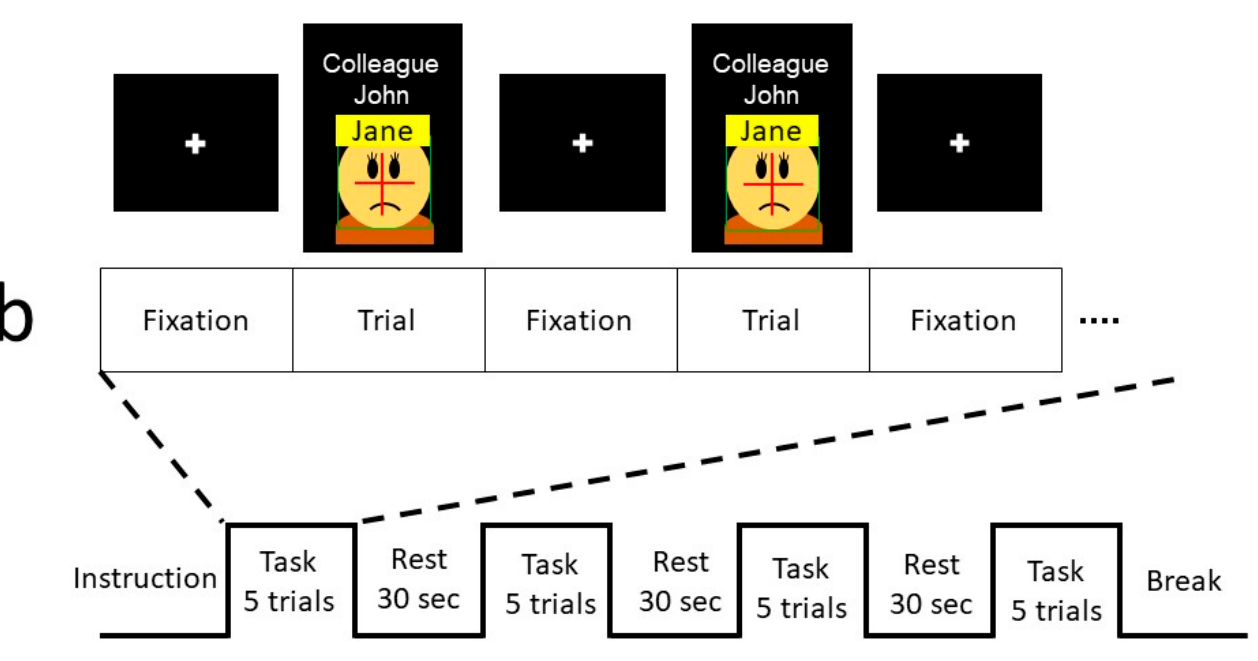
Figure 2. Functional MRI procedure for the present study. Session 1 ( a ) and session 2 ( b ) of the study are shown. The patient was instructed to determine whether the face image matched the name and relationship information displayed on the screen.